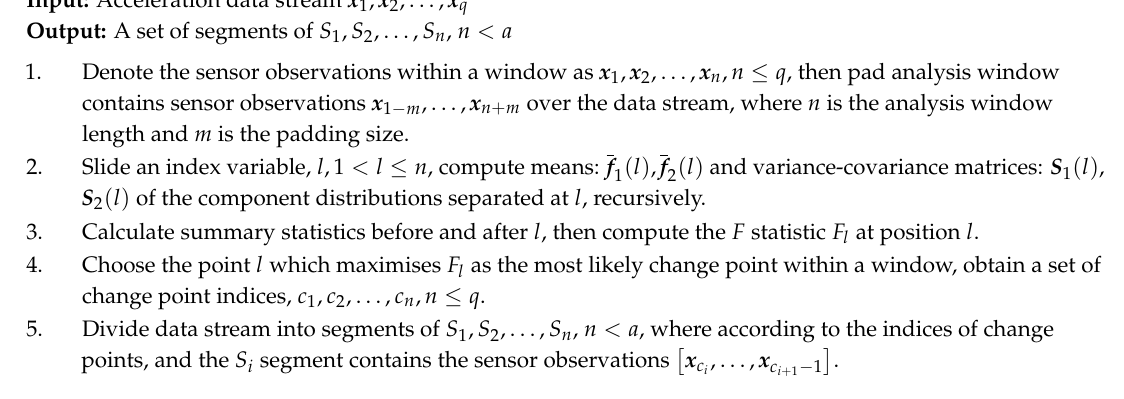
Algorithm 1. Chang Point-Based Data Segmentation.